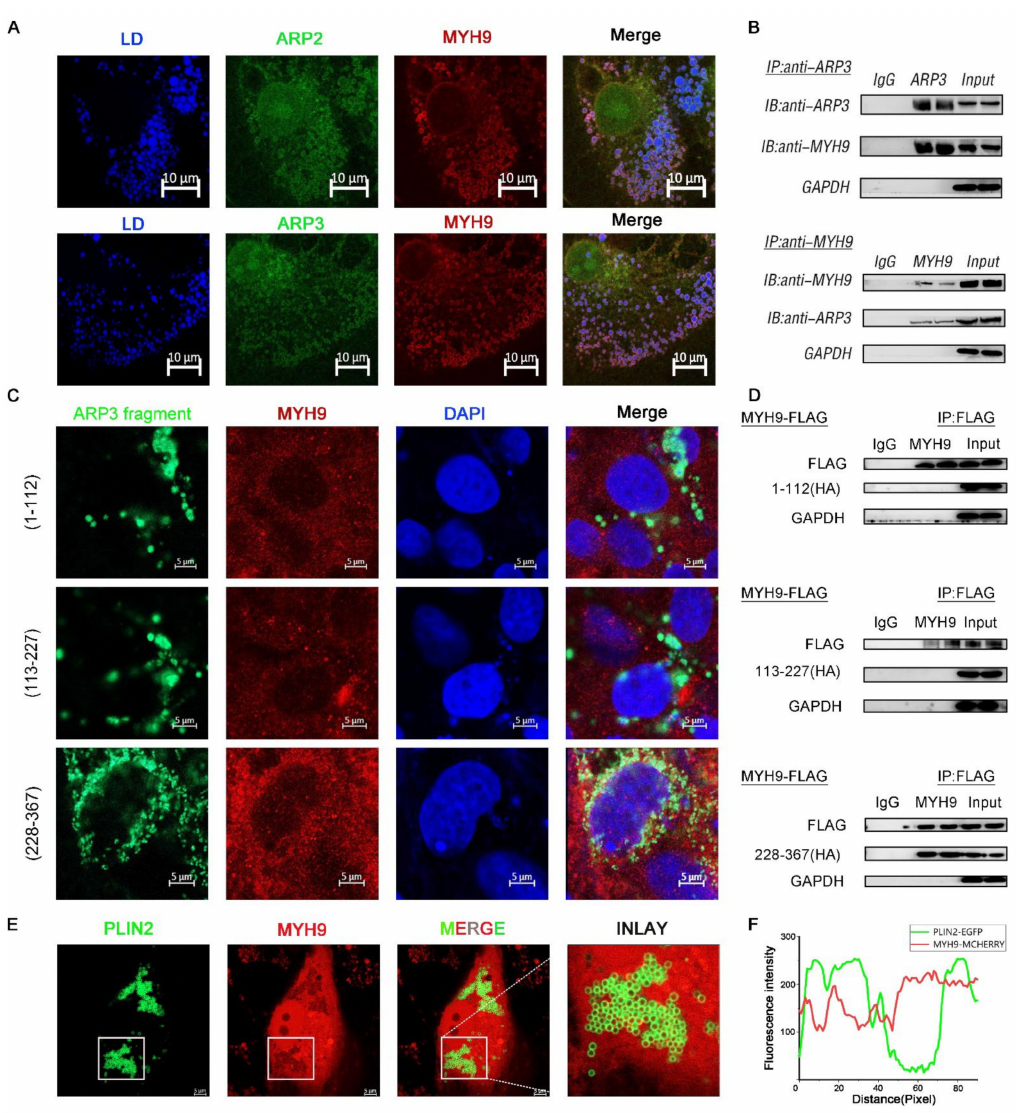
Figure 3. MYH9 interacted with ARP3 for LD movement. ( A ) Subcellular localization of ARP2 or ARP3 and MYH9, bar, 10 µ m ( B ) The binding of ARP3 and MYH9 detected by co- immunoprecipitation. ( C ) Subcellular localization of ARP3 truncation fragments and MYH9, bar, 5 µ m. ( D ) The binding of ARP3 truncation fragments and MYH9 detected by co-immunoprecipitation. ( E ) Subcellular localization of Plin2 and MYH9, bar, 5 µ m. ( F ) The Fluorescence intensity analysis of ( E